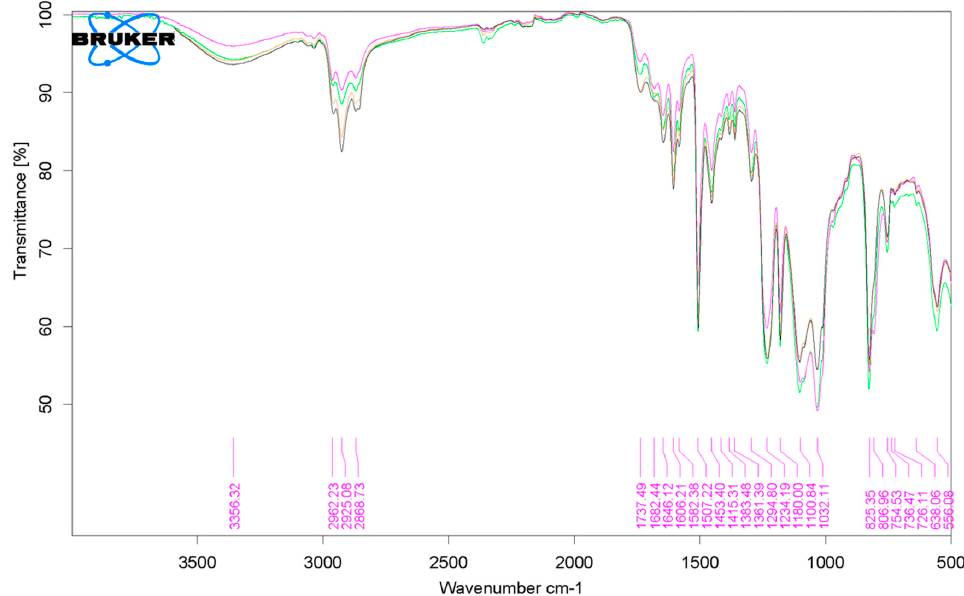
Figure 7. FTIR spectra obtained for bulk plate specimens, showing chemical changes in the alkane region between the control/unaged (green and pink lines) and aged samples (black and yellow lines).